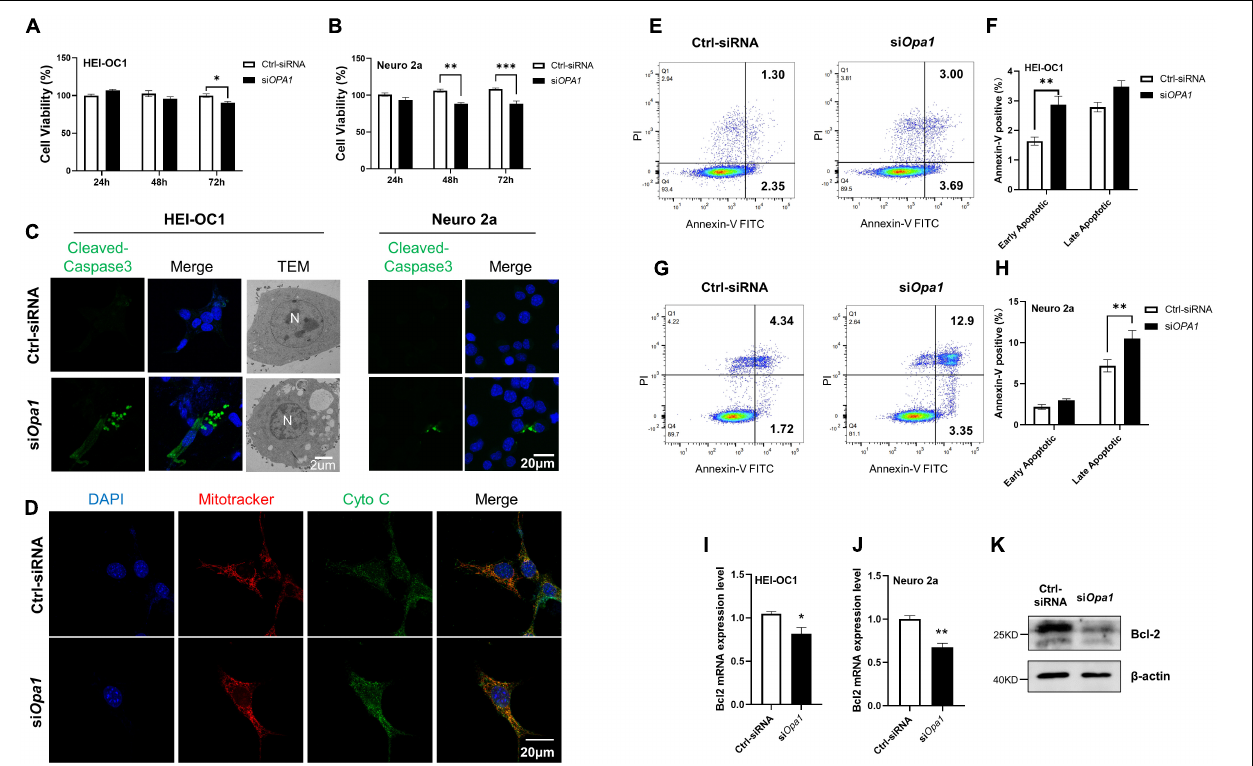
FIGURE 3 | Lacking Opa1 triggers apoptosis in HEI-OC1 and Neuro 2a cells. (A,B) CCK-8 was used to assess the cell viability of HEI-OC1 (A) and Neuro 2a (B) cells cultured for 24, 48, and 72 h after transfection with scramble siRNA (Ctrl) or si Opa1 . * p < 0.05, ** p < 0.01, *** p < 0.001 (two-way ANOVA). (C) Representative confocal microscopic images of cleaved caspase-3 staining at 24 h after siRNA transfection of HEI-OC1 and Neuro 2a cells. Representative transmission electron microscopic images of HEI-OC1 cells at 24 h after siRNA transfection. (D) Representative confocal images of HEI-OC1 cells co-stained for mitochondria (MitoTracker) and cytochrome c at 24 h after siRNA transfection. (E) Representative flow cytometric plots generated from HEI-OC1 cells stained with Annexin V-FITC/PI to detect apoptosis at 24 h after transfection with scramble siRNA (Ctrl) or si Opa1 . (F) The percentages of early and late apoptotic cells were compared between Ctrl-siRNA- and si OPA1 -transfected HEI-OC1 cells. ** p < 0.01 (two-way ANOVA). FITC, fluorescein isothiocyanate; PI, propidium iodide. (G) Representative flow cytometric plots generated from Neuro 2a cells stained with Annexin V-FITC/PI to detect apoptosis at 24 h after transfection with scramble siRNA (Ctrl) or si Opa1 . (H) The percentages of early and late apoptotic cells were compared between Ctrl-siRNA- and si OPA1 -transfected Neuro 2a cells. ** p < 0.01 (two-way ANOVA). (I,J) Quantification of Bcl2 mRNA expression levels in HEI-OC1 (I) and Neuro 2a (J) cells transfected with siRNA for 24 h. * p < 0.05, ** p < 0.01 (non-parametric Mann-Whitney t -test). (K) Representative Western blot images showing Bcl2 protein levels in Neuro 2a cells transfected with siRNA for 48